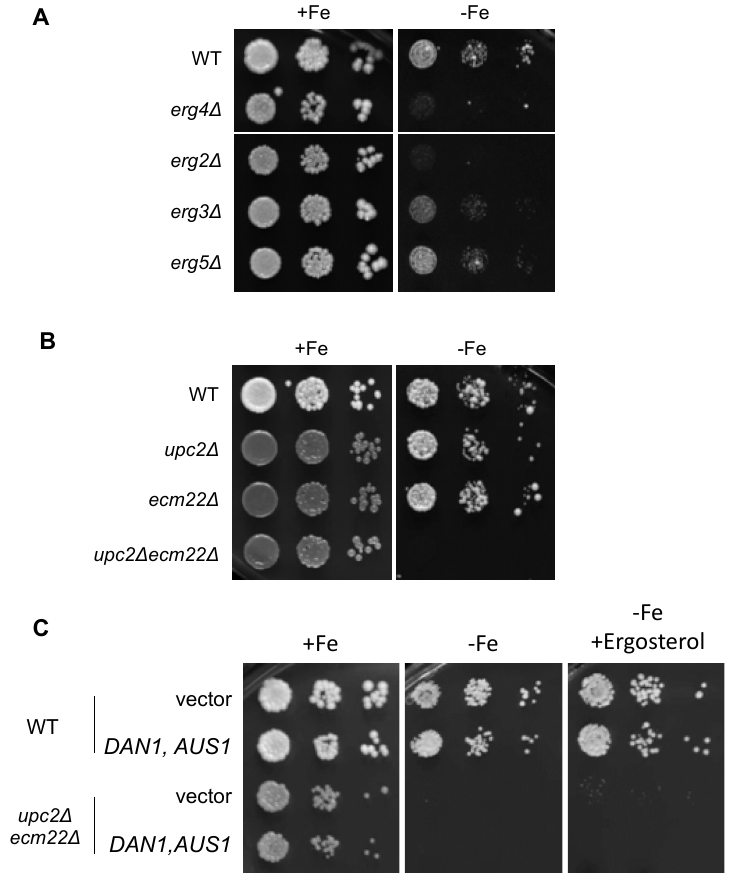
Figure 5. Ergosterol biosynthesis is essential for a proper adaptation of yeast to iron deficiency. ( A ) Single mutants of non-essential ERG genes exhibit growth defects under iron depletion. Wild-type (WT, BY4741), erg4 Δ , erg2 Δ , erg3 Δ , and erg5 Δ cells were spotted in 10-fold serial dilutions on SC (+Fe) and SC supplemented with 600 µM Ferrozine ( − Fe). ( B ) The simultaneous deletion of UPC2